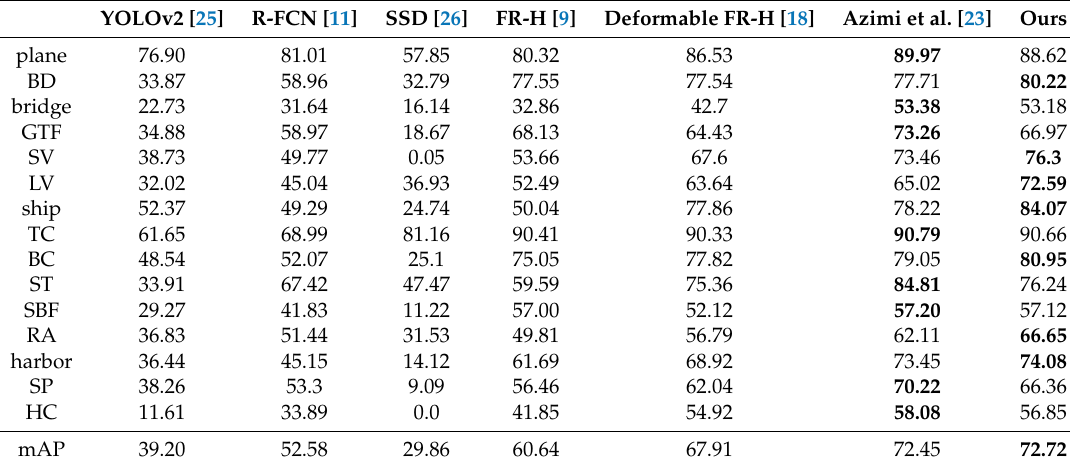
Table 9. Quantitative comparison of the baseline and our method on the HBB task in test set of DOTA dataset FR-H stands for Faster R-CNN[6] trained on HBB. The best results on each category is highlight in